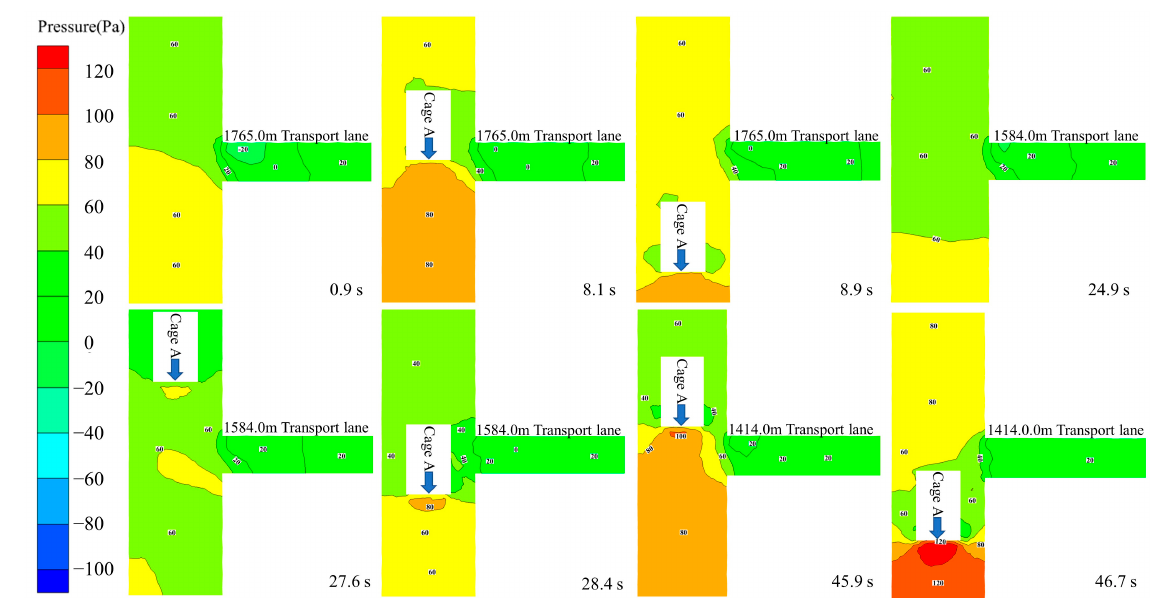
Figure 11. Pressure field distribution of each transport lane in x = 1 m section.